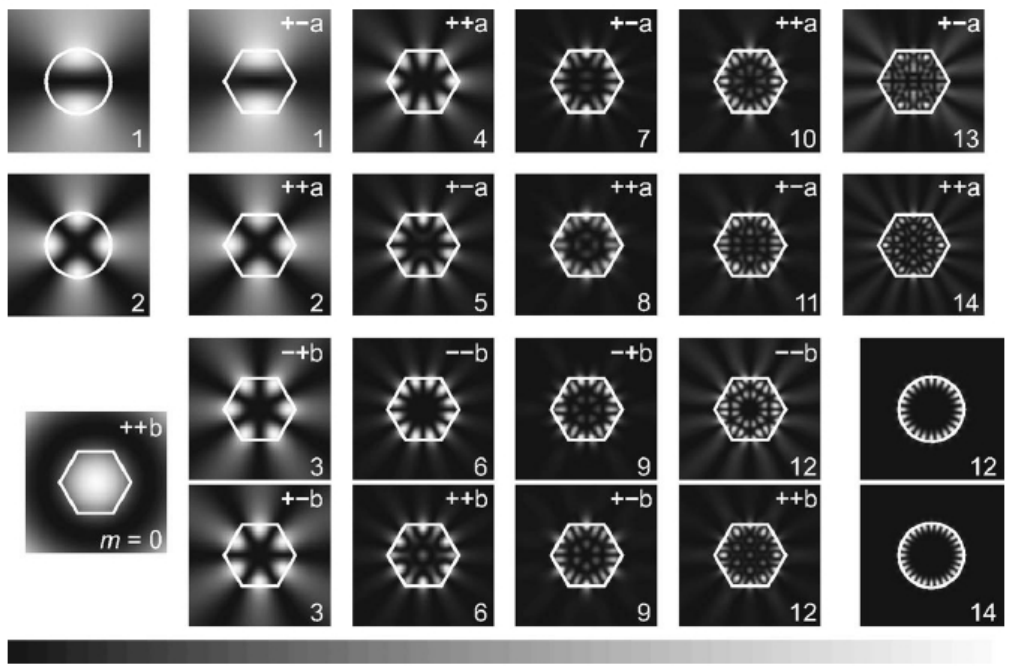
Figure 2: Several configurations of Whispering Gallery resonance modes in infinite long cylindrical and hexagonal nanowire. For com- parison, four mode patterns of the circular cavity are given in the upper left and lower right together with their angular mode number. (Reprinted with permission from [85], © 2005 by the American Physical